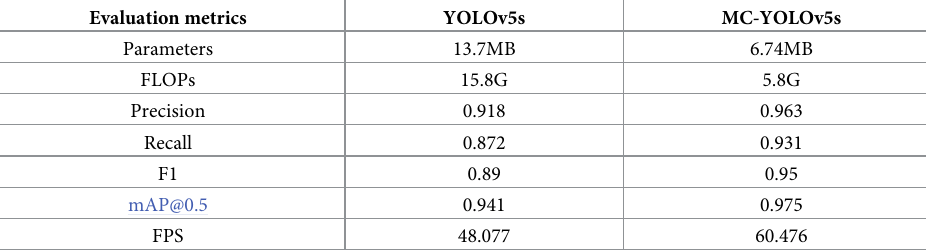
Table 4. Performance comparison between YOLOv5s and